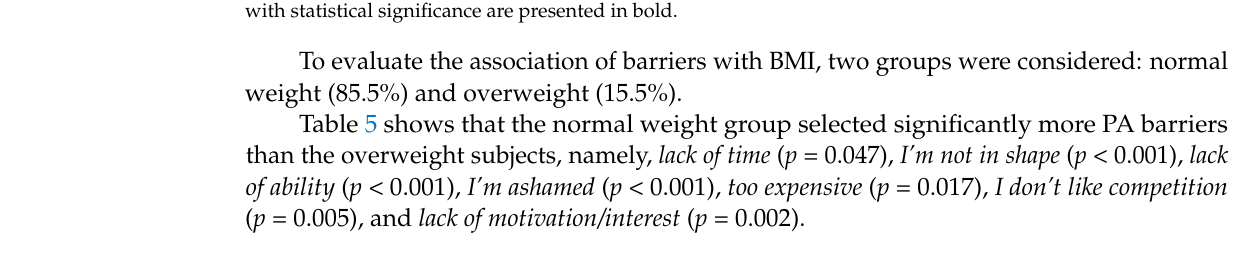
Table 5. PA barriers stratified by BMI (two